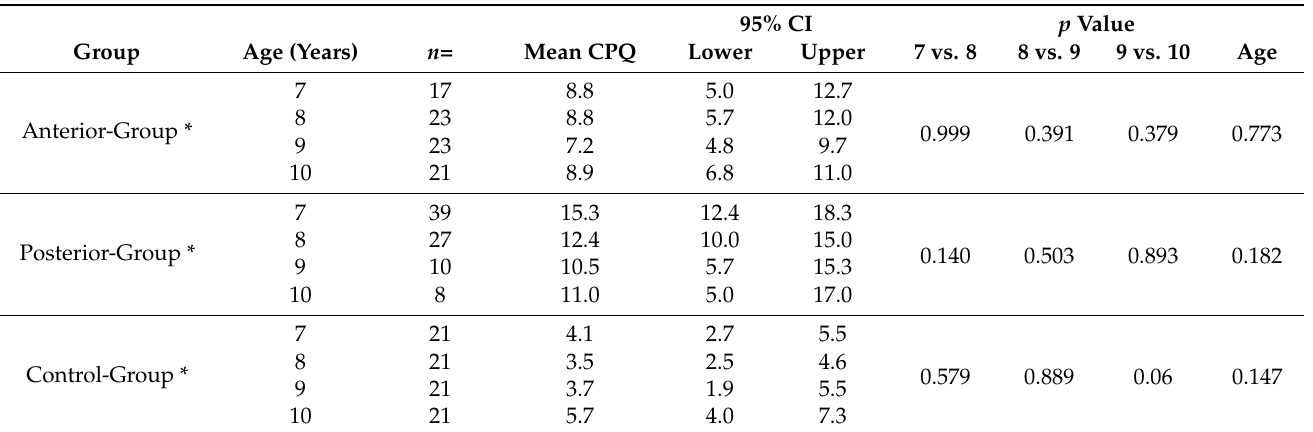
Table A5. Test for significant differences between mean of Total-CPQ-Scores in the Anterior-, Posterior- and the Control-Group and their age.